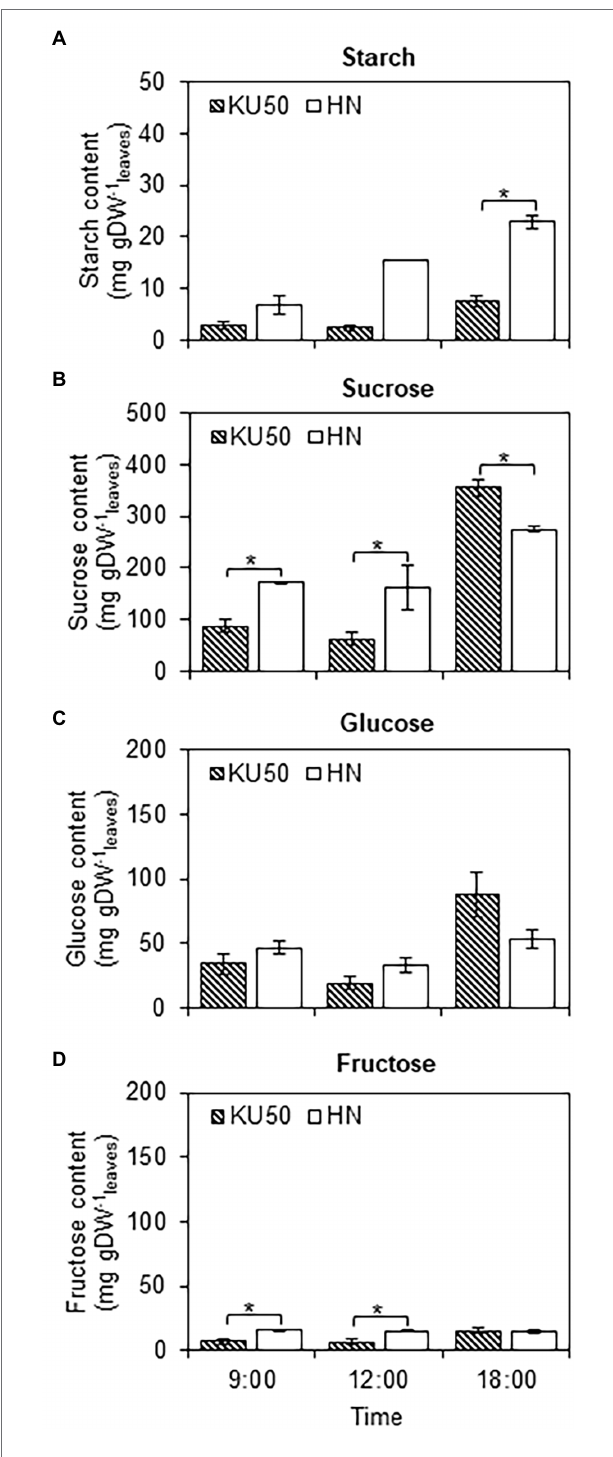
FIGURE 4 | Changes in leaf starch (A) , sucrose (B) , glucose (C) , and fructose (D) contents of Kasetsart 50 (KU50) and Hanatee (HN) cassava varieties at 15 WAP in diurnal conditions, on a dry weight basis. Each result is the mean ± SE of values obtained from three biological replicates. Statistical significance, based on a one-sided Student’s t -test, is denoted by * p ≤ 0.05. gDW, gram dry